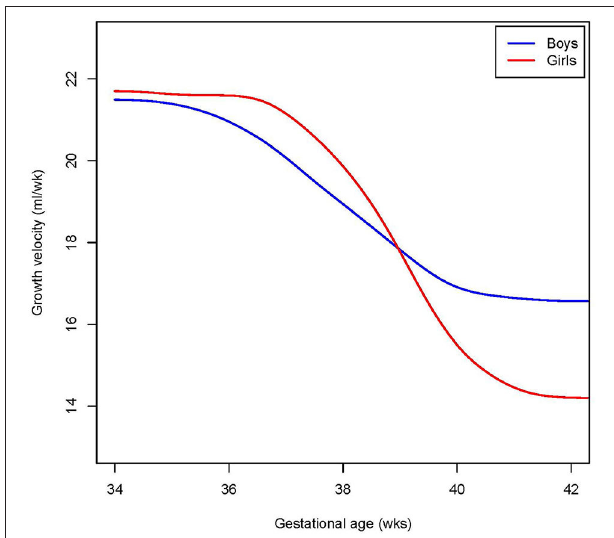
FIGURE 2 | Cranial volume growth rate. Shown is the extrapolated median growth rate per week by gestational age, in girls and boys for those tracking the